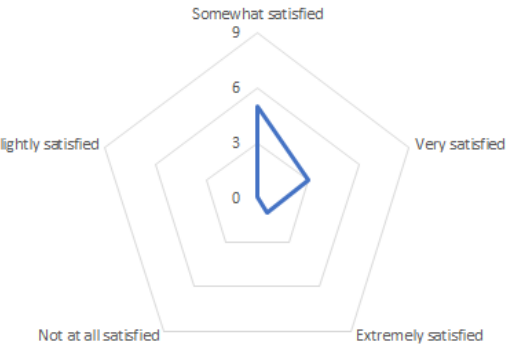
Figure 6. Evaluator’s satisfaction with the look and feel of the system. Scale (0, 3, 6, 0) represents the number of participants in each category.